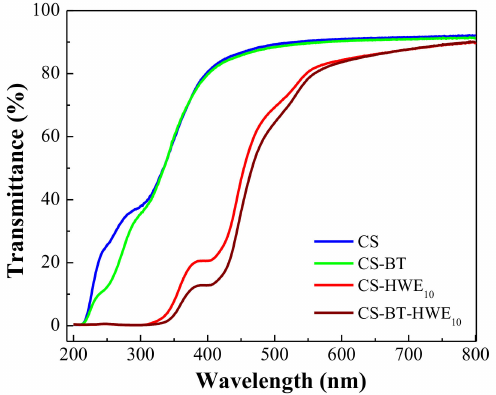
Figure 2. UV–Vis transmittance spectra for pure chitosan films, CS-BT, CS-HWE 10 and CS-BT-HWE 10 composite